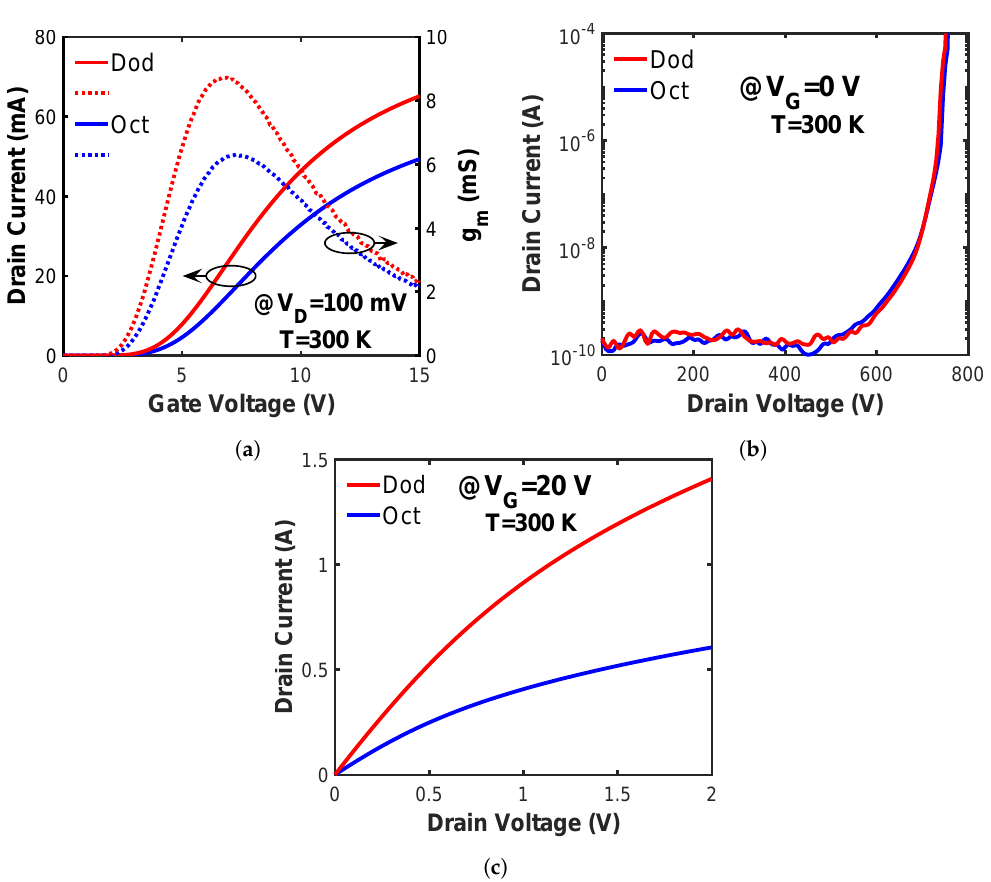
Figure 2. ( a ) Transfer characteristics at V D = 100mV (solid line: drain current vs. gate voltage; dash line: transconductance vs. gate voltage), ( b ) blocking characteristics at V G = 0V, and ( c ) output characteristics at V G = 20V, for the 650 V SiC power MOSFETs with Dod and Oct